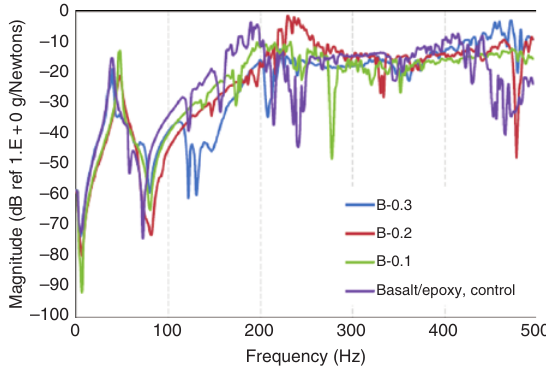
Figure 4: The frequency response curves of the samples.